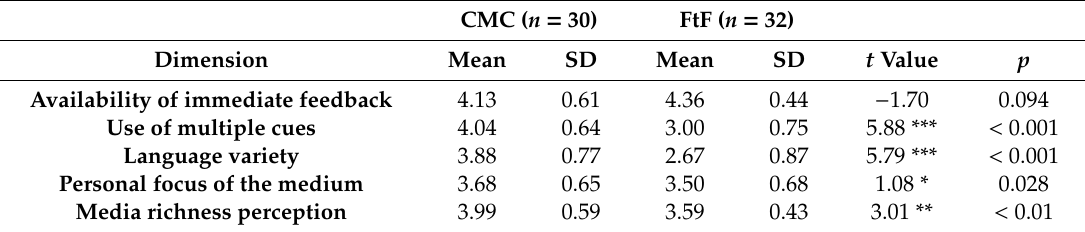
Independent sample t -test analysis of media richness perception in a norm-referenced